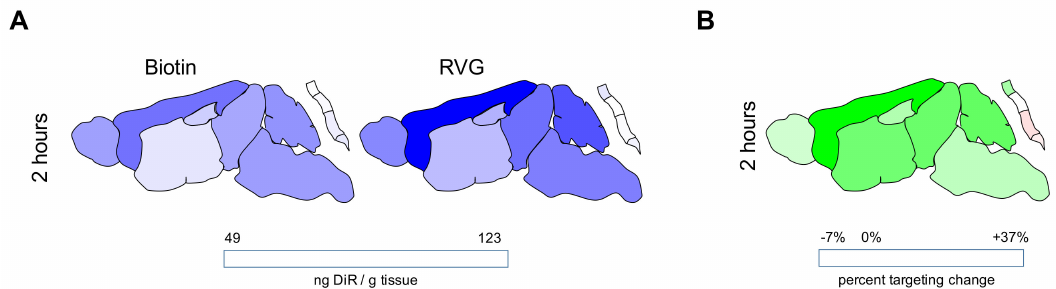
Figure 7. Delivery of payload from intravenously administered nanoparticles varies by CNS region and surface modification; these data were previously published [15] and are replicated here for direct comparison to Figure 5. ( A ) Magnitude of DiR delivered from ctr-NPs (left) or RVG-NPS (right) nanoparticles. Data are scaled to min / max concentration for the entire intravenous data set. ( B ) Percent targeting change calculated by dividing the concentration of DiR delivered from RVG-NPS nanoparticles by the concentration of DiR delivered from ctr-NPs nanoparticles for each tissue region. Data are scaled to the min / max concentration for the entire intravenous data set such that a value of 0 represents no di ff erence in delivery from a targeted nanoparticle compared to a control